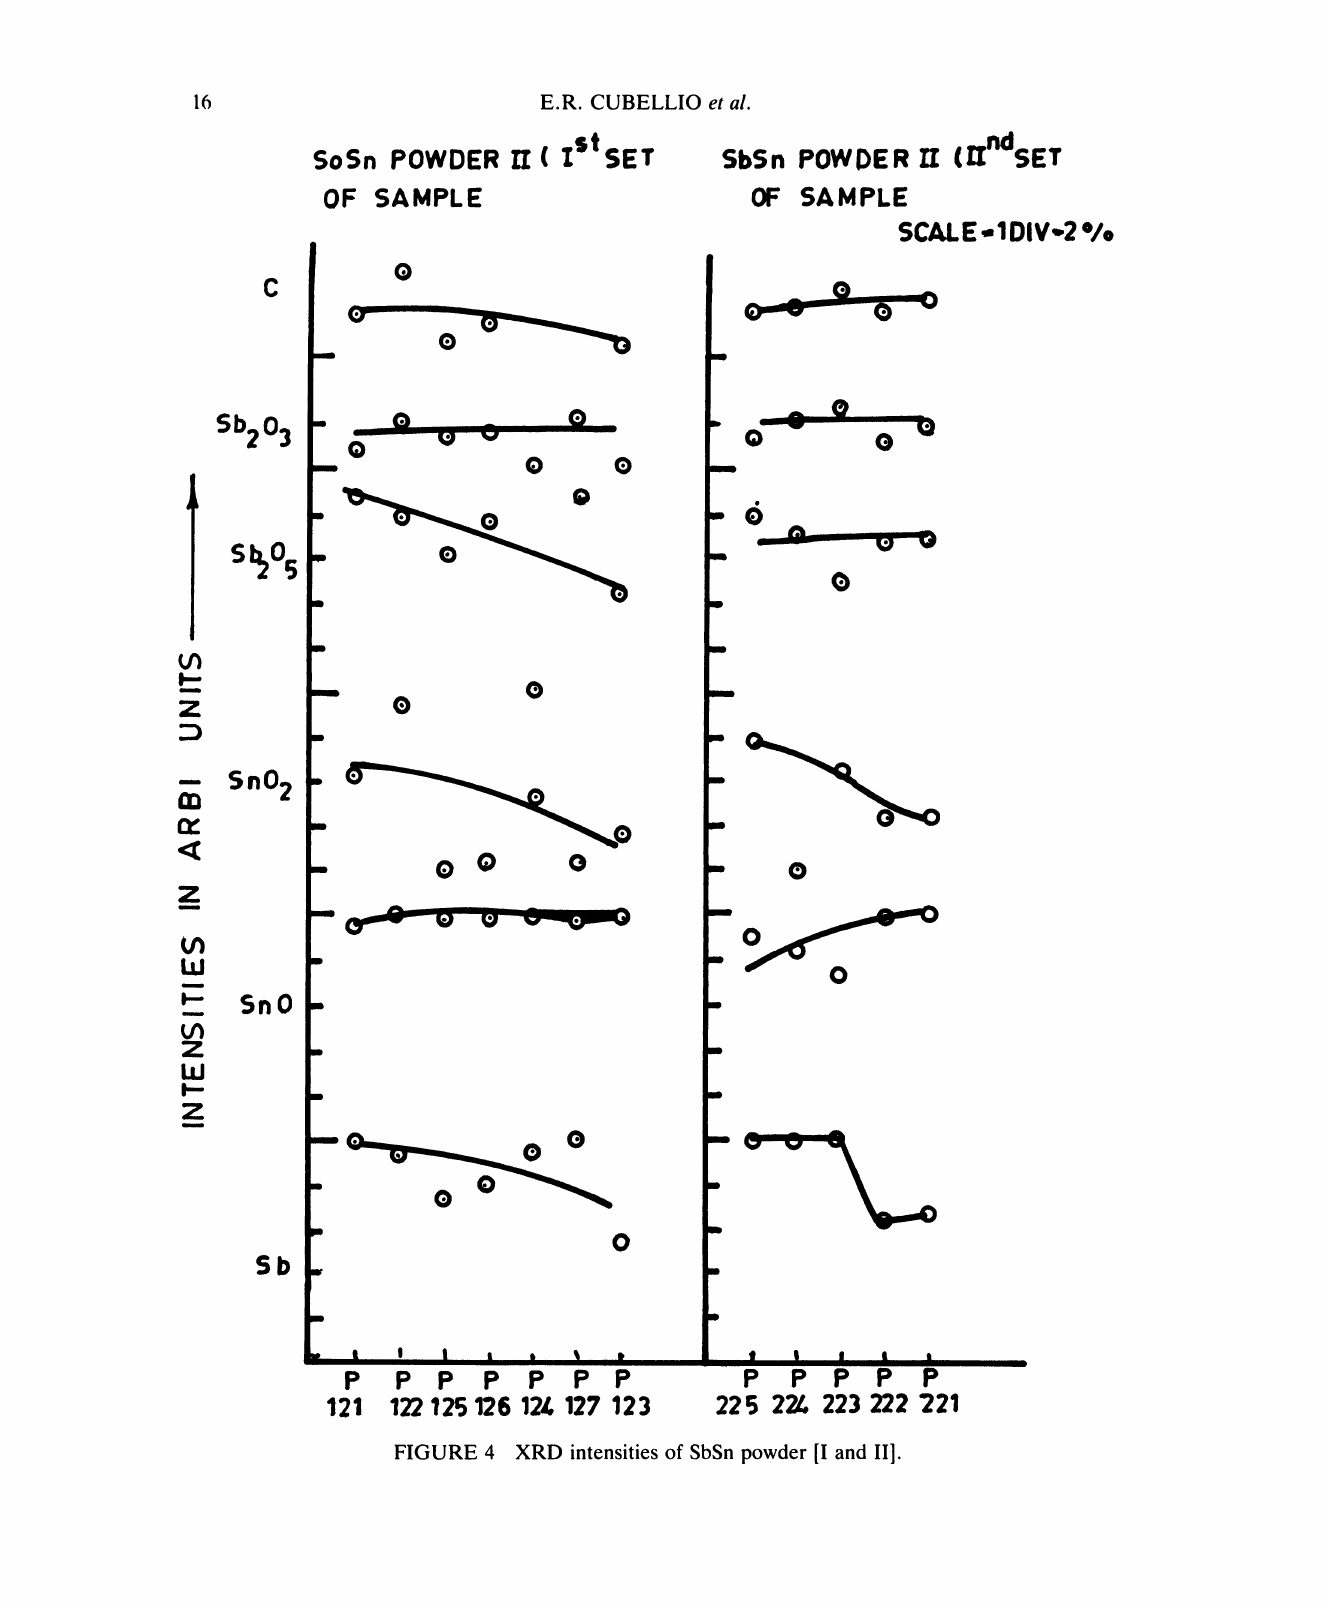
FIGURE 4 XRD intensities of SbSn powder [I and